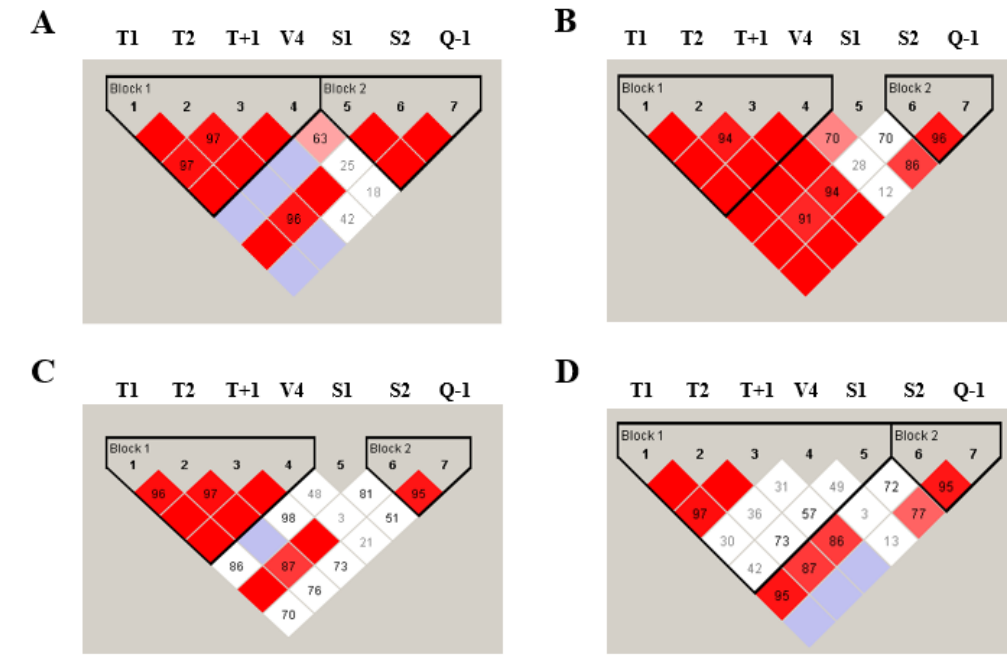
Figure 1. Linkage disequilibrium (LD) of ADAM33 genetic variants found among healthy and asthmatic subjects. The LD of healthy adults ( A ), asthma adults ( B ), healthy children ( C ), and asthma children ( D ) was carried out using Haploview software. The red squares represent a strong LD and the white squares represent a weak LD. The blue squares indicate that there is no LD.